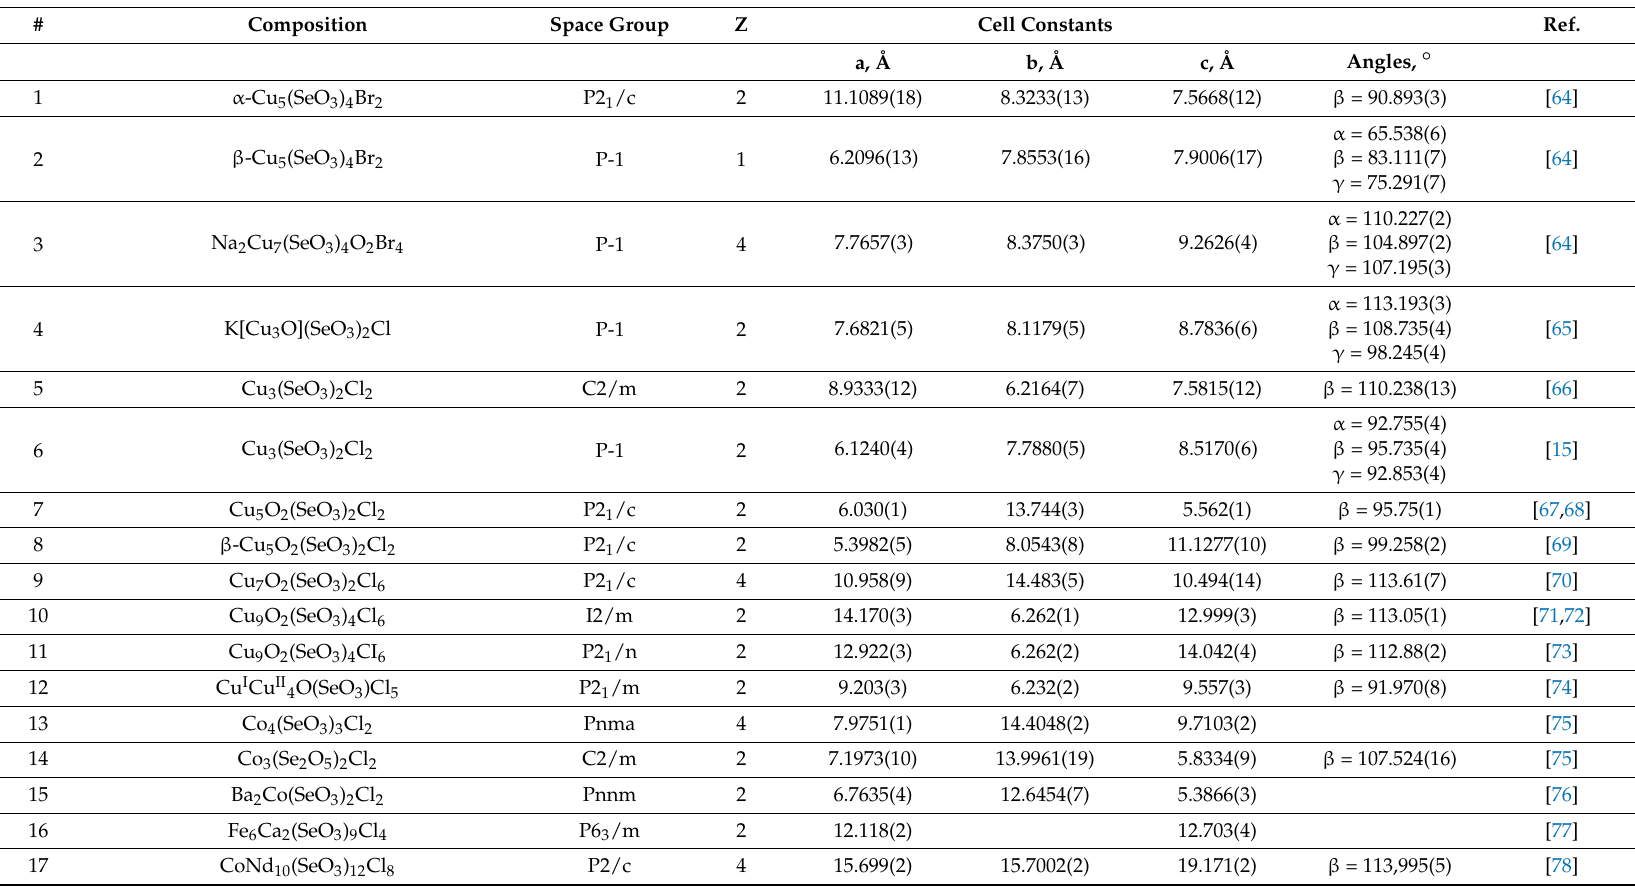
Table 3. Compositions and crystallographic data for transition metals selenite halides with possible magnetic exchange between d-metal